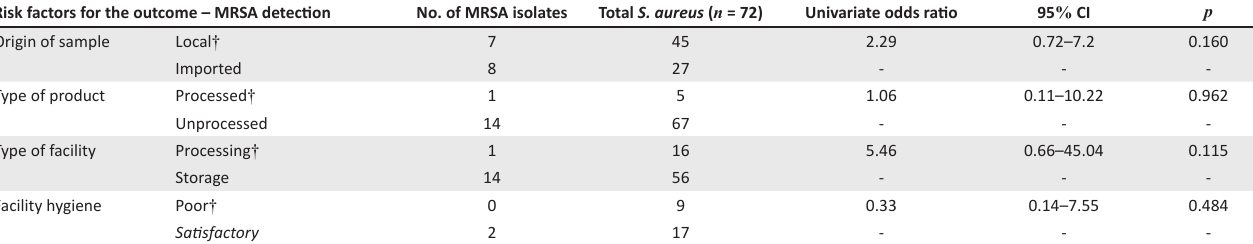
TABLE 5: Univariate logistic regression results for methicillin-resistant Staphylococcus aureus detection as the outcome. Risk factors for the outcome – MRSA